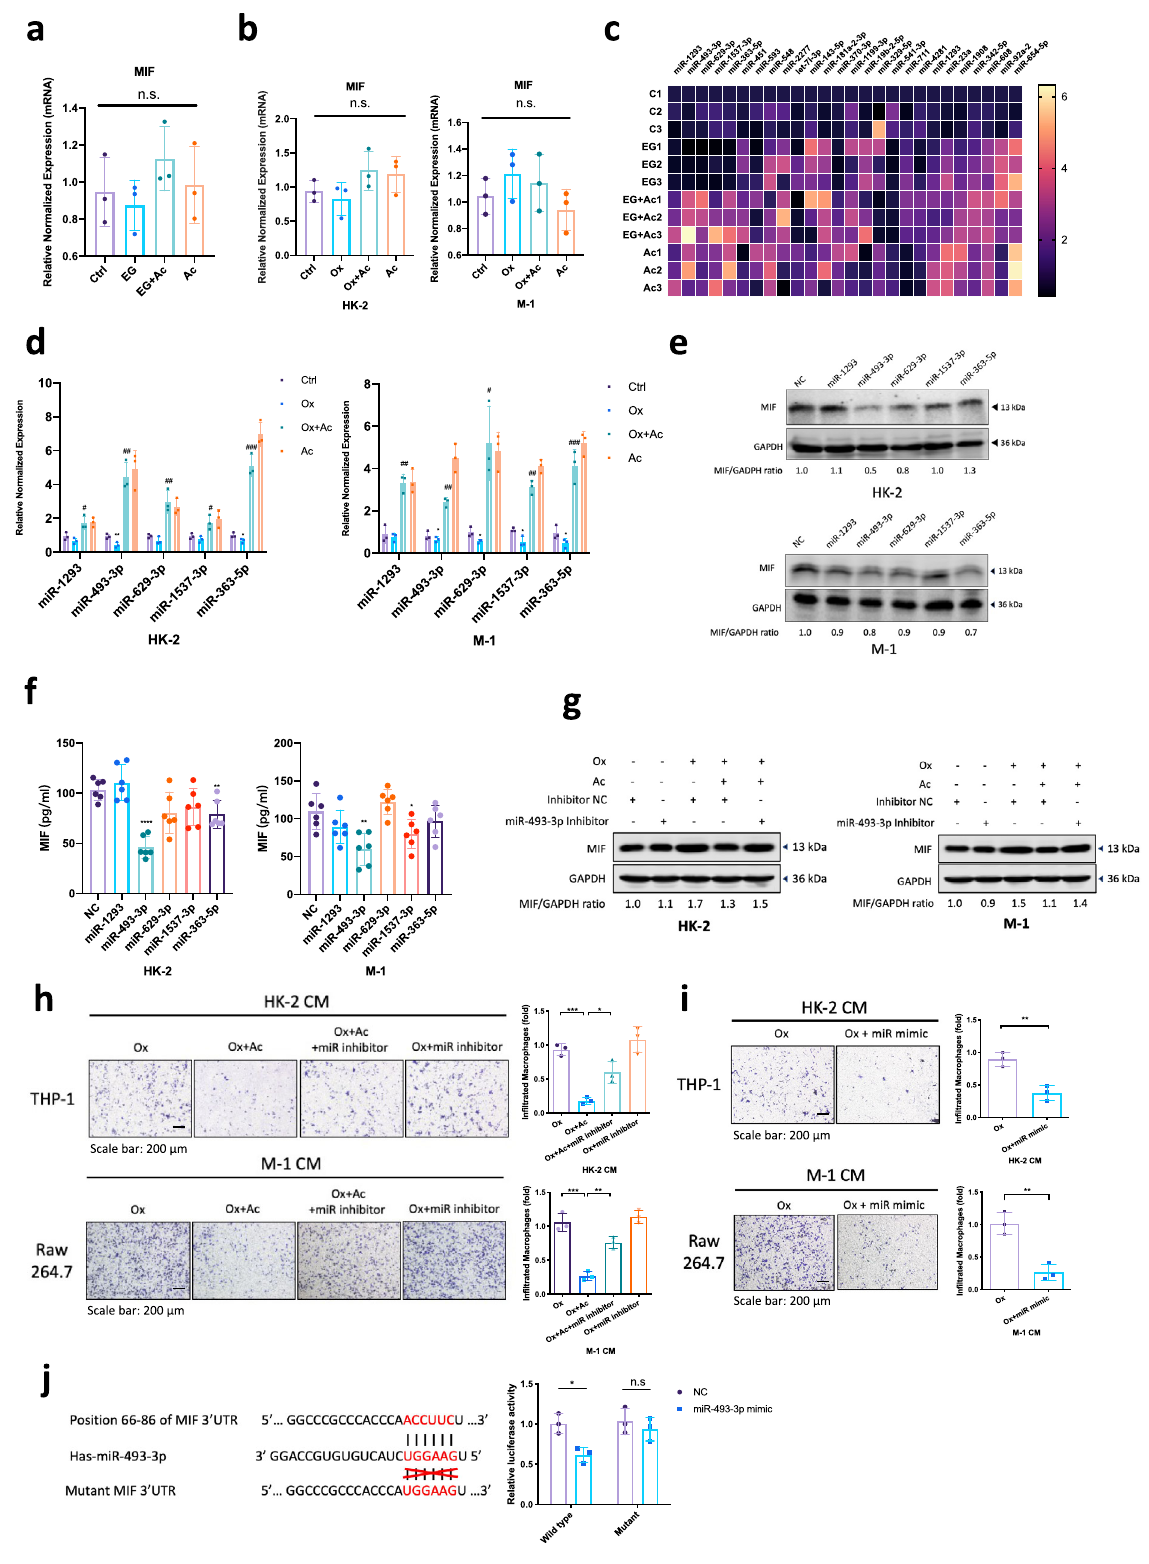
Mechanism dissection of how acetate promotes miR-493-3p expression: via restoring histone acetylation . To dissect the molecular mechanisms of how acetate promoted the expression of miR-493-3p , we fi rst focused on histone acetylation since previous studies showed that acetate could function as an epigenetic metabolite to regulate gene expression 12,15 . We treated HK-2 and